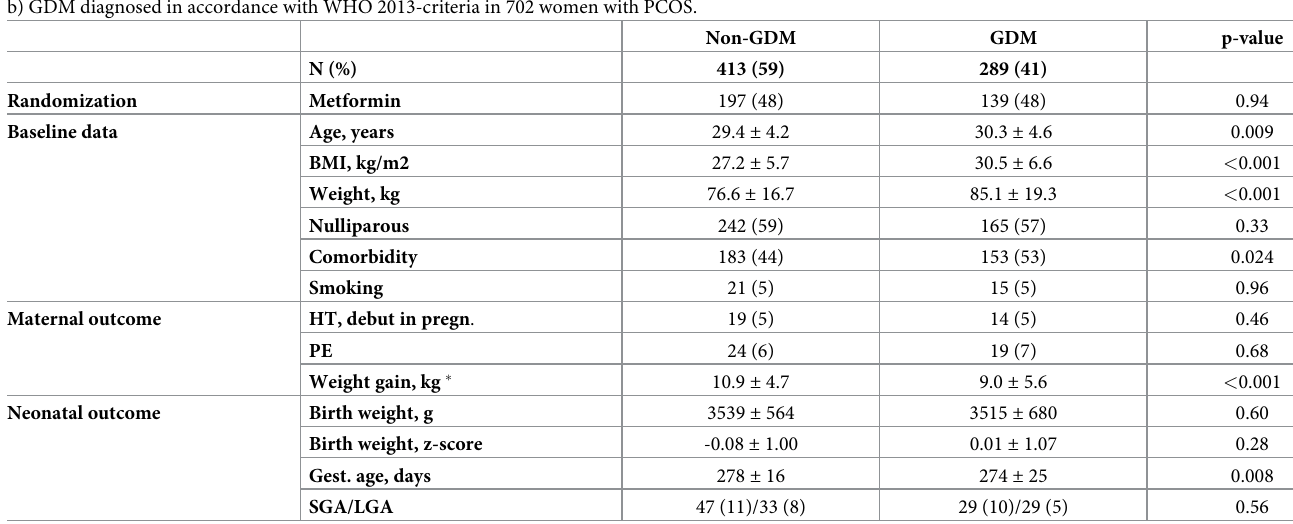
lower birth weight was not found when the WHO 2013 the Norwegian 2017 GDM criteria were used. However, there was no difference in birth weight z-score or the proportion of SGA and LGA neonates between women with or without GDM using any of the GDM criteria, see Table 1a and 1b (WHO criteria) and S1 Table (Norwegian criteria). Offspring birth weight z-score showed a positive correlation to maternal weight and BMI at inclusion, parity and maternal weight gain during pregnancy (p < 0.001 for all), but only a trend towards correlation with fasting glucose level at inclusion (p = 0.045). In linear regres- sion analysis, maternal age and BMI at inclusion, parity and maternal gestational weight gain during pregnancy correlated to offspring birth weight z-score. GDM according to WHO 1999